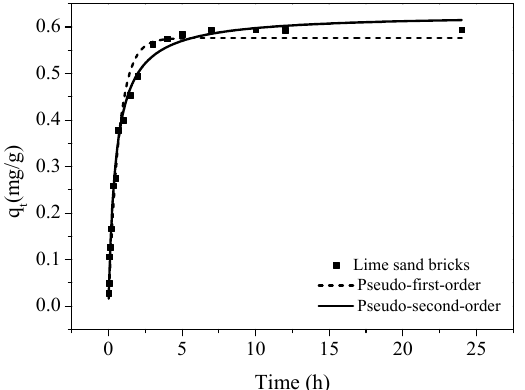
Figure 4. The kinetics of Cu(II) removal by lime sand brick bricks at 25 °C ( C 0 = 5 mg/L, solid-liquid ratio = 8 g/L, stirring speed = 135 rpm, pH =